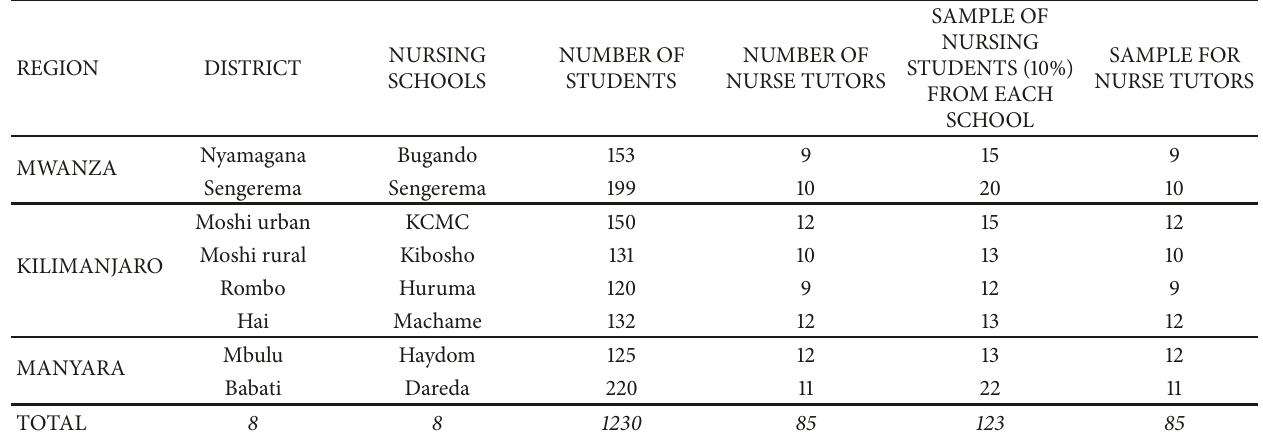
Table 1: Regions, districts, nursing schools, number of students, and nurse tutors.